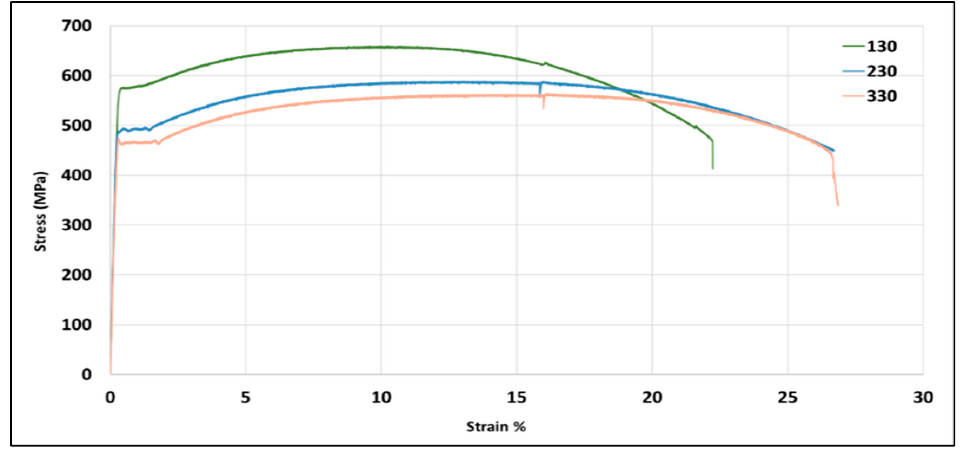
Figure 9. Stress–strain diagram comparing the average behavior of the tensile testing of 130, 230, and 330.